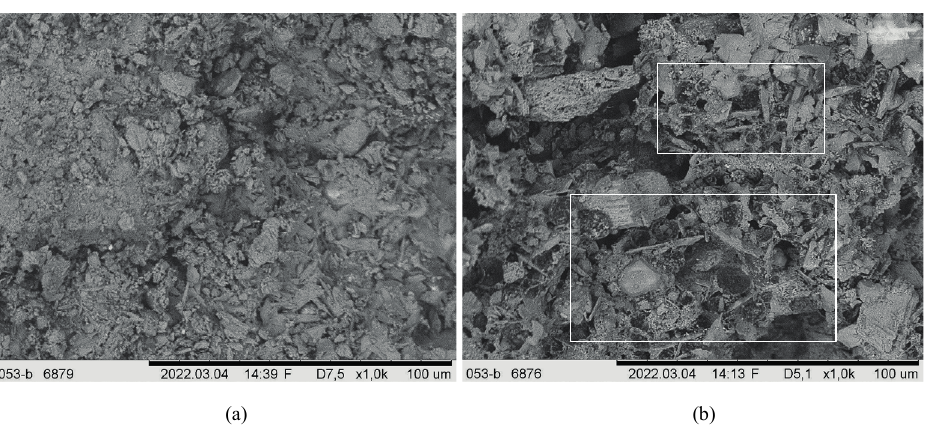
Fig. 4. The microstructure of gypsum hempcrete: a) reference composition without PCM; b) PCM20 with 20wt.% of